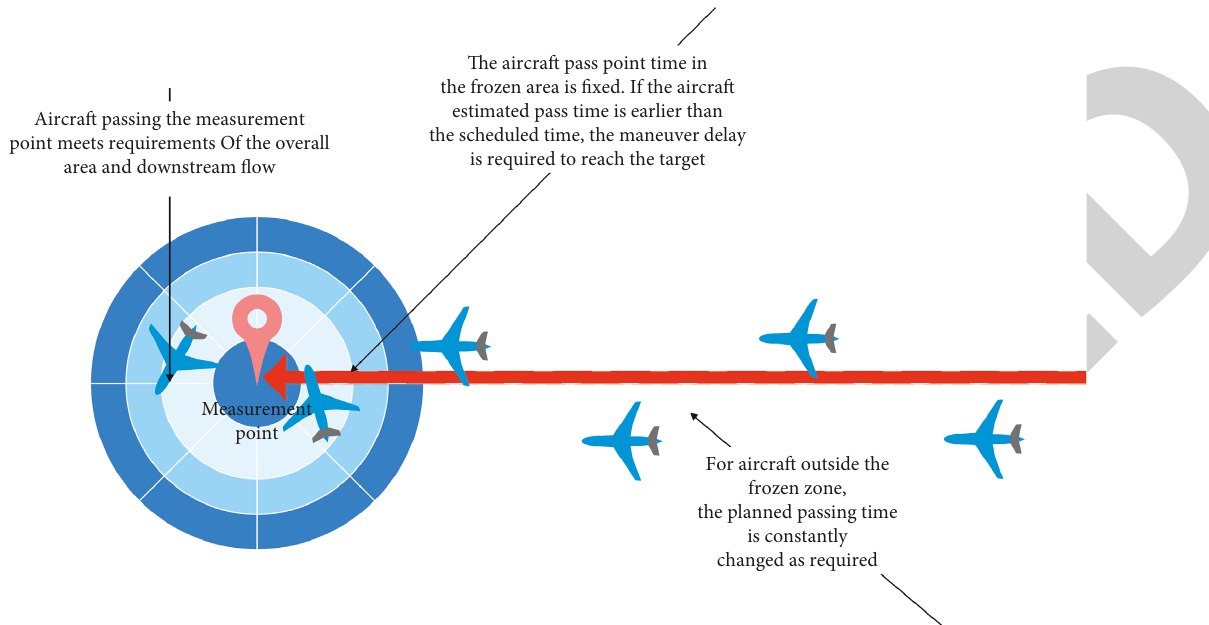
Figure 3: Schematic diagram of freezing